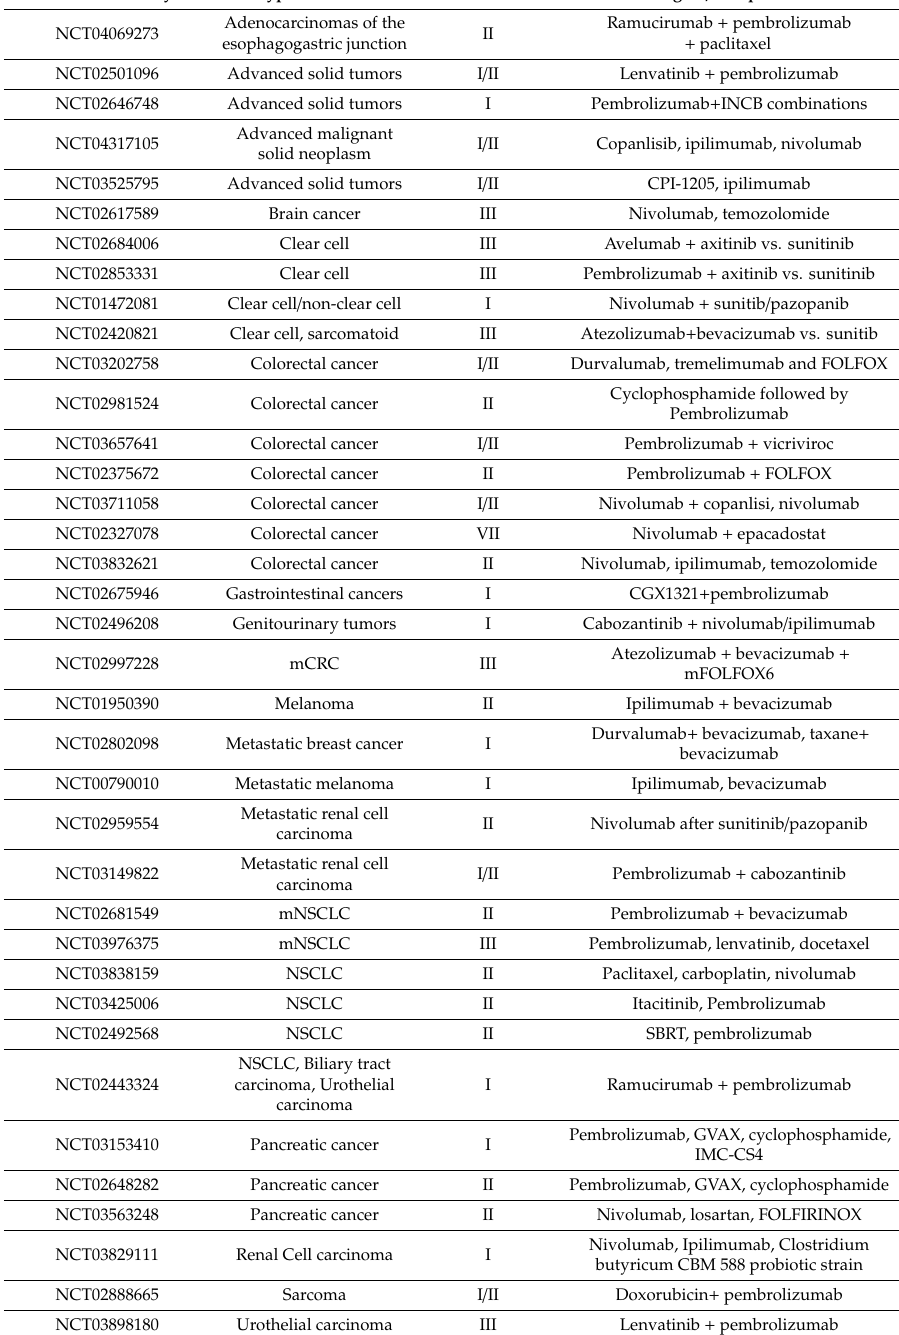
Table 1. Clinical studies with combination of immunotherapy with chemotherapy in solid tumors. Number of